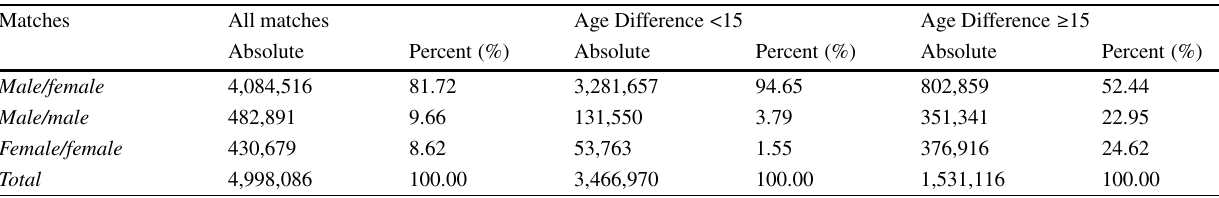
Table 3 Gender Composition of Matched Potential